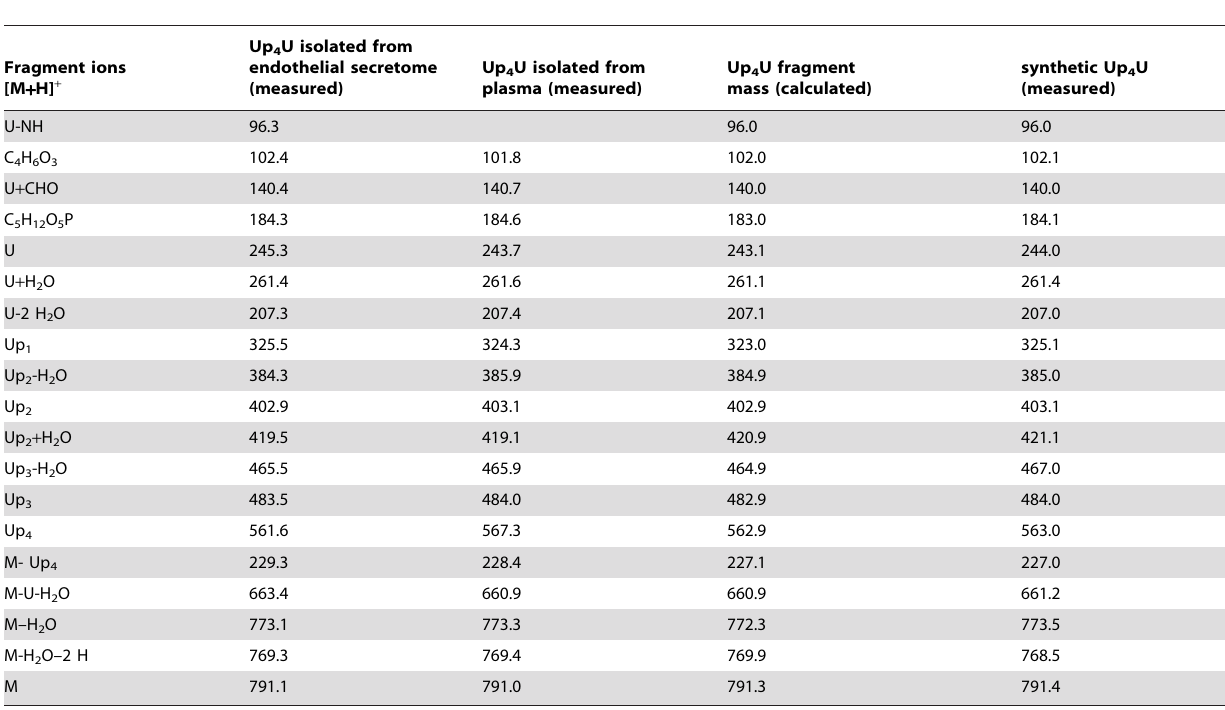
Table 1. Molecular masses of Up 4 U fragments obtained by MALDI-TOF-TOF mass spectrometry ( Figure 1.B)